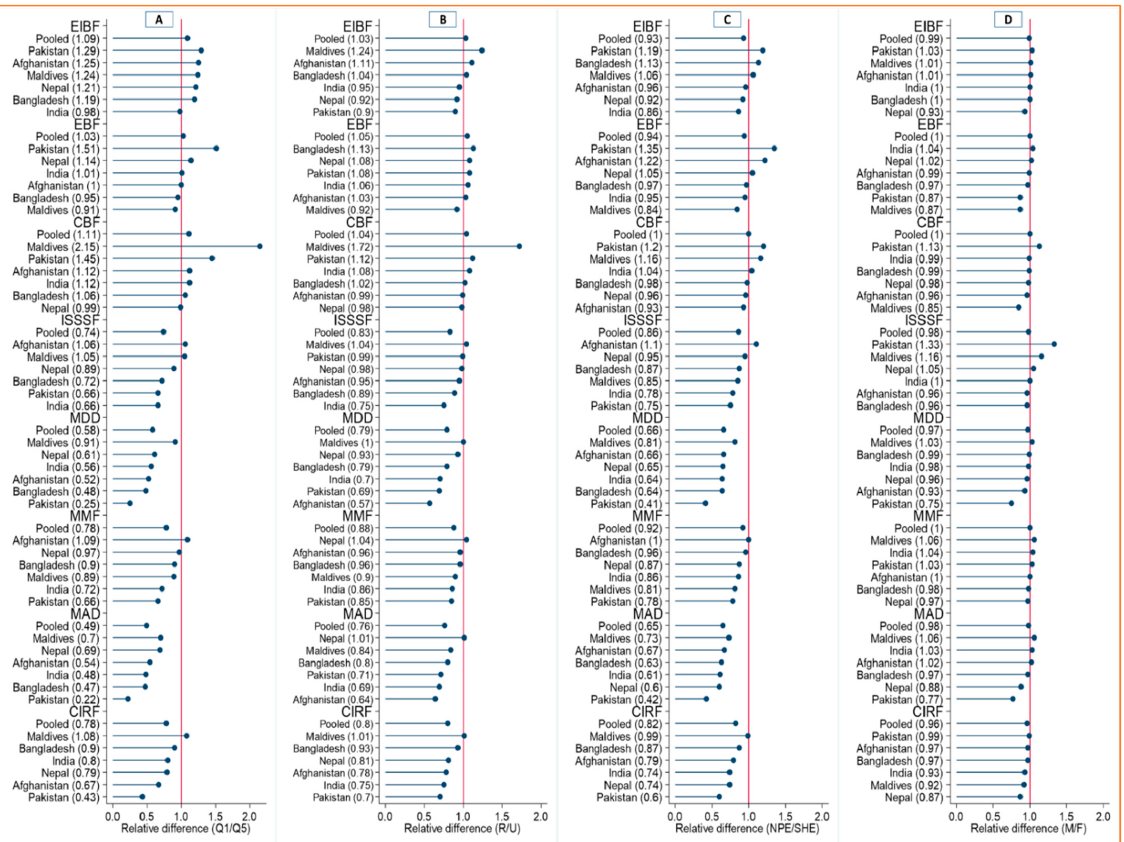
Figure 3. Relative gaps in the prevalence of IYCF indicators across equity dimensions in South Asian countries. EIBF = Early initiation of breastfeeding, EBF = Exclusive breastfeeding, CBF = Continued breastfeeding at 1 year, ISSSF = Introduction of solid semi-solid and soft foods, MDD = Minimum dietary diversity, MMF = Minimum meal frequency, MAD = Minimum acceptable diet, CIRF = Con-